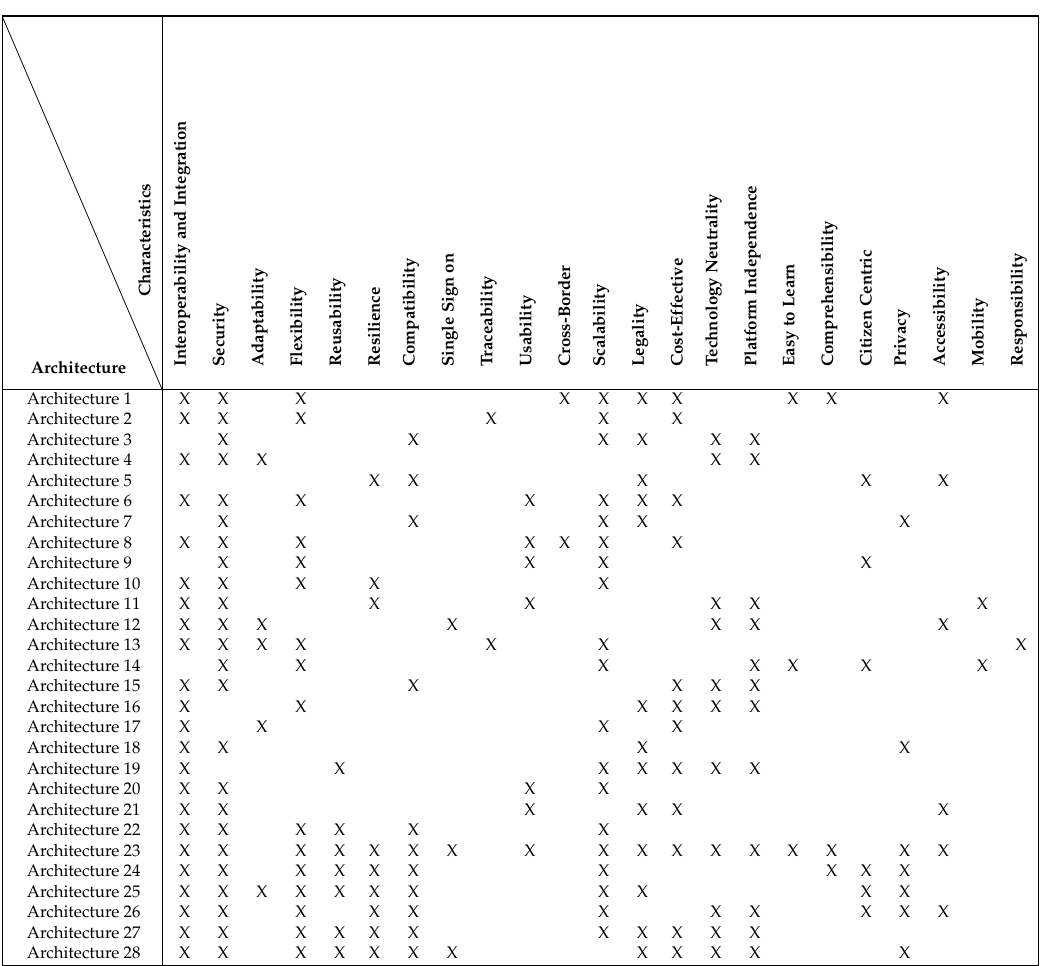
Table A2. Comparative table of Digital Government architectures (presented in Table 3) against the characteristics (presented in Section